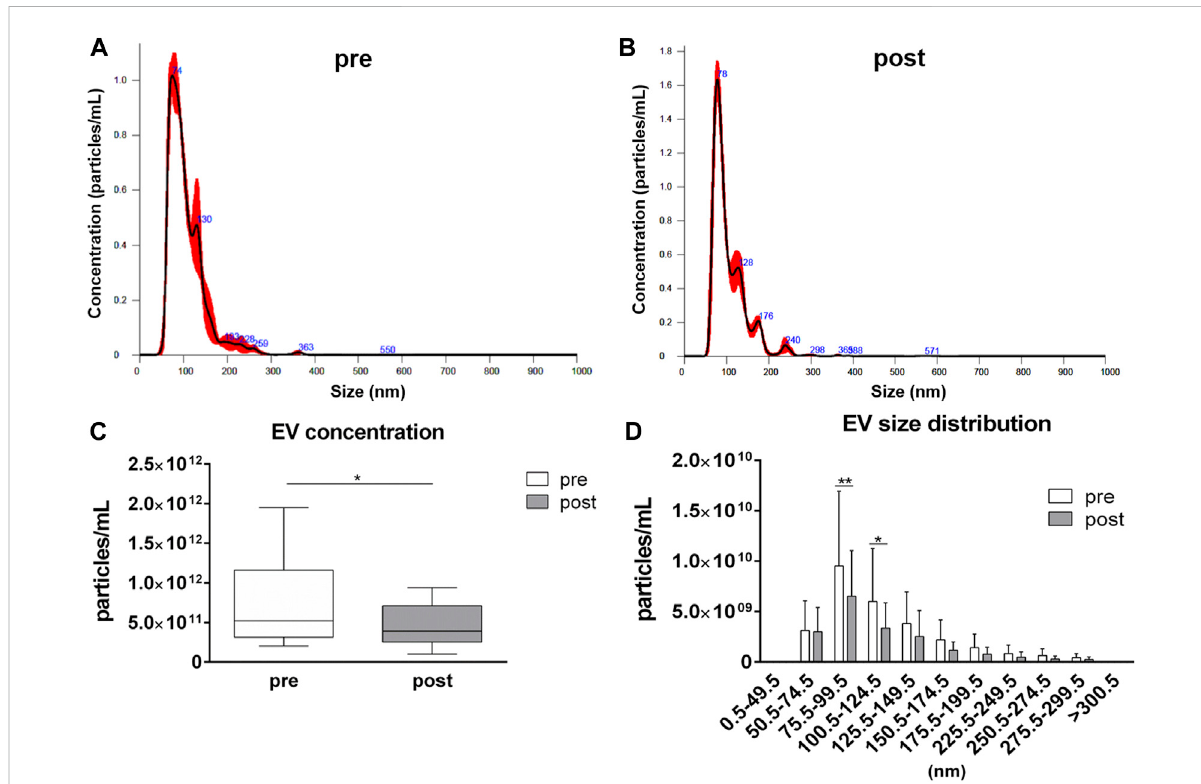
FIGURE 1 Concentration and size distribution of extracellular vesicles in plasma. Extracellular vesicle analysis for (A) pre-competition and (B) post- competition plasma samples was performed using Nanosight300. Comparison of total concentration (C) and size distribution (D) between pre- and post-competition plasma was analyzed. Statistical analysis was performed with Prism ® v6.01 (GraphPad Software). Plasma-EV total concentration data are expressed as min. to max. and were compared using a paired t test; plasma-EV size distribution data are expressed as mean ± SD and were compared using Sidak ’ s multiple comparison test. The differences were considered signi fi cant when p < 0.05. Asterisks indicate signi fi cant intergroup differences (* p < 0.05, ** p < 0.01, *** p <